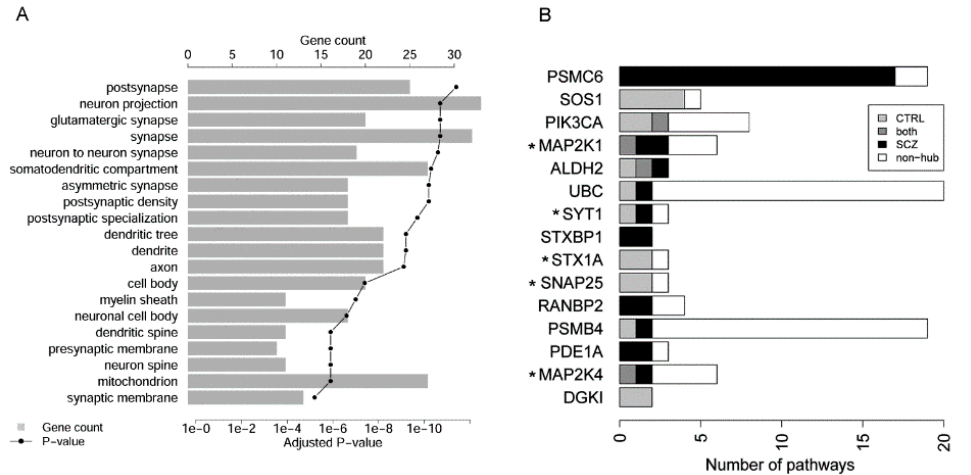
Figure 3. Cellular localization and pathway affiliation of pivotal pathway hub genes. ( A ) Top 20 significantly overrepresented cellular components of 92 pivotal genes. From top to bottom, components were ordered by decreasing statistical significance. ( B ) Number of pathways where a pivotal gene appeared as a hub. Genes were ordered by the number of pathways (colored bar length) where the gene appeared as a hub in either control (CTRL) or SCZ samples. Five gene products localized in “neuron projection” were labeled by asterisk (*).